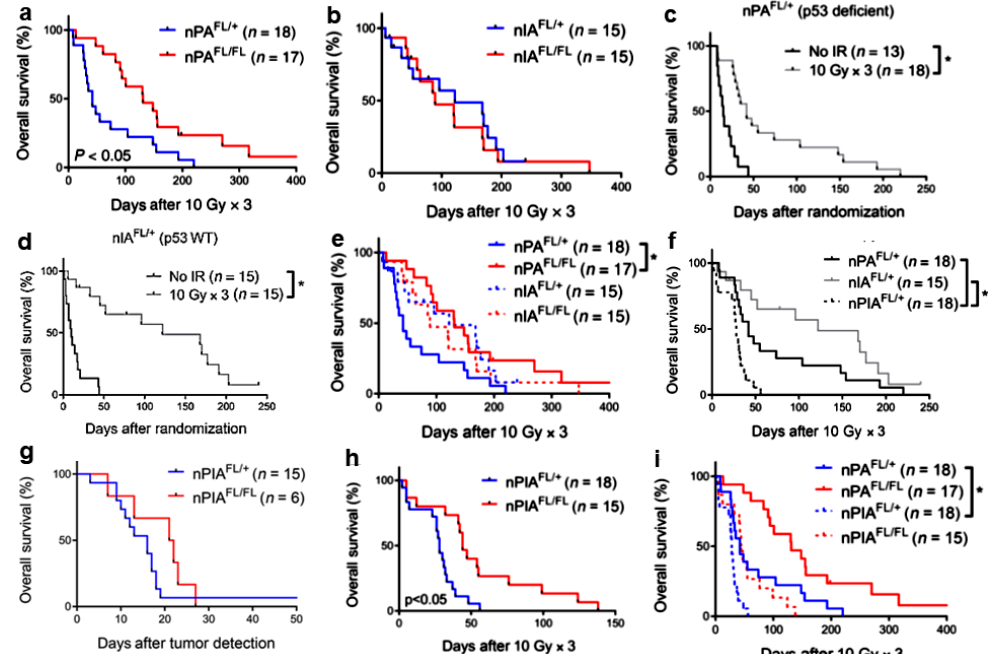
Figure 3. Tumor genotype dictates radiosensitization after Atm deletion in primary brainstem glioma models. ( a ). Deletion of Atm in p53-deficient gliomas improves tumor response to IR. Kaplan–Meier plot of overall survival in tumor-bearing mice after three daily fractions of 10 Gy RT delivered to the whole brain. *, p < 0.05 by log rank test. ( b ). Deletion of Atm does not radiosensitize p53 wild-type gliomas. Kaplan–Meier plot of overall survival in tumor-bearing mice after three daily fractions of 10 Gy RT delivered to the whole brain. *, p < 0.05 by t test (2 tailed). ( c , d ). p53 wild-type gliomas with intact ATM function are sensitive to IR. Kaplan–Meier plot of overall survival in ( c ) p53-deficient tumor-bearing nPA FL/+ mice or ( d ) p53 wild-type tumor-bearing nIA FL/+ mice that received no RT or were treated with three daily fractions of 10 Gy to the whole brain. ( e ). Kaplan–Meier plot comparing the survival of mice with p53 wild-type and p53-deficient gliomas treated with fractionated RT. The animals included in these survival curves are the same animals from the survival studies in panels ( a ) and ( b ). *, p < 0.05 by log rank test. ( f ). p53 signaling mediates radiosensitivity of Ink4a/Arf-deficient gliomas. Kaplan–Meier plot comparing the survival of nPA FL/+ , nIA FL/+ , and nPIA FL/+ mice after treatment with three daily fractions of 10 Gy delivered to the whole brain. Control nPA FL/+ and nIA FL/+ curves were taken from panels ( a ) and ( b ). *, p < 0.05 by log rank test. ( g – i ). Deletion of Atm improves the radiation response of gliomas driven by loss of p53 and Ink4a/Arf. ( g ) Kaplan–Meier plot of overall survival in tumor-bearing mice after tumor detection. ( h ) Kaplan–Meier plot of overall survival in tumor-bearing mice after three daily fractions of 10 Gy RT delivered to the whole brain. ( i ) Kaplan–Meier plot comparing the survival of mice with p53-deficient gliomas and gliomas lacking both p53 and Ink4a/Arf that were treated with fractionated RT. Control nPA FL/+ and nPA FL/FL curves were taken from panels ( a , b ). *, p < 0.05 by t test (two-tailed) when comparing the mean of two groups or log rank test when comparing survival curves. Tumor genotypes/phenotypes. nPA FL/+ , nestinTVA p53 FL/FL Atm FL/+ lacking p53; nPA FL/FL , nestinTVA p53 FL/FL Atm FL/FL lacking both p53 and ATM; nIA FL/+ , nestinTVA Ink4a/Arf FL/FL Atm FL/+/ lacking Ink4a/Arf; nIA FL/FL , nestinTVA Ink4a/Arf FL/FL Atm FL/FL/ lacking both Ink4a/Arf. and Atm; nPIA FL/+ , nestinTVA p53 FL/FL Ink4a/Arf FL/FL Atm FL/+ lacking both p53 and Ink4a/Arf (modified after [69] with